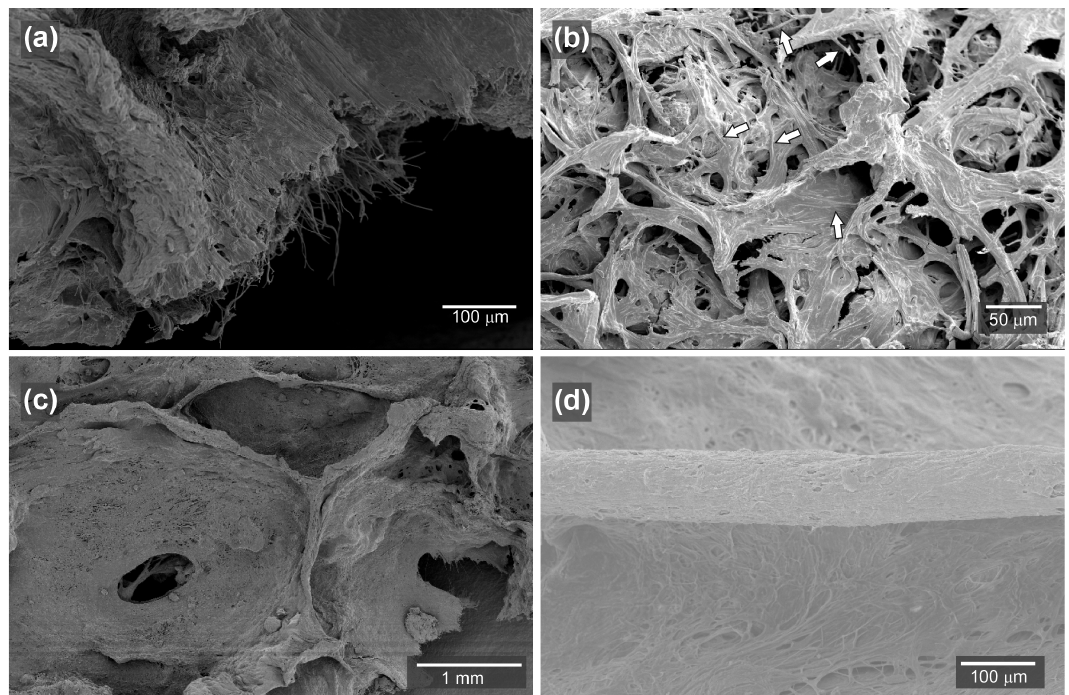
Figure 7. SEM macrographs showing the structure of the dried mat in the lakes: (a) transversal section of the mat with visible cyanobacterial filaments; (b) surface structure of the mat, the position of cyanobacterial filaments incorporated within mucilaginous matrix is indicated by arrows; (c) general view of the surface structure of the mat with the net formed by mucilage (compare with Fig. 7d); (d) detail of the same mucilaginous